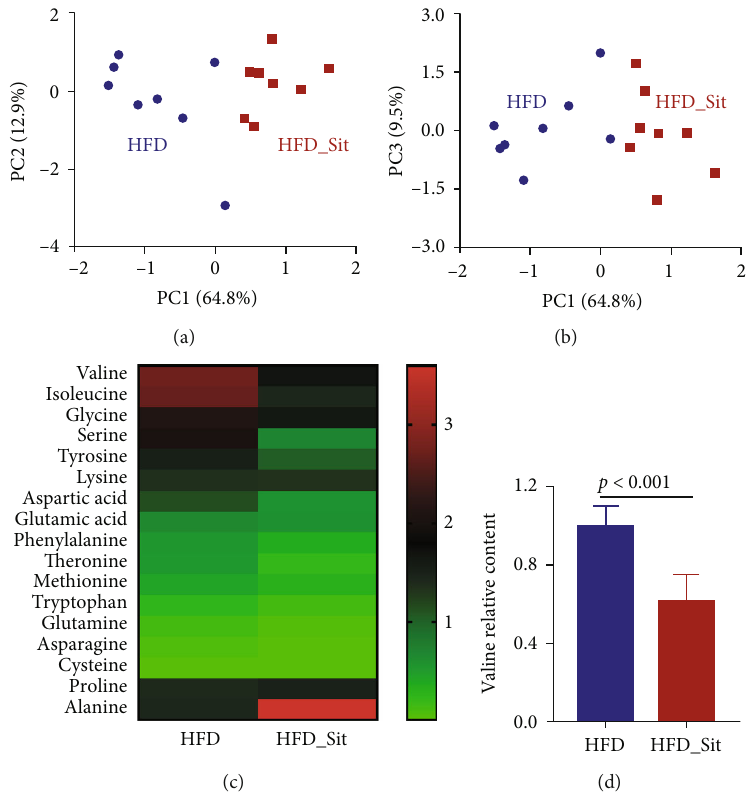
Figure 1: Sitagliptin treatment reduced the valine levels in HFD-fed mice. (a, b) Cluster analysis of the HFD-fed and HFD_Sit mice based on the amino acid concentrations using PCA. The principal components (PC1, PC2, and PC3) from the PCA are plotted for each sample. The percentage of variation covered in the plotted principal components is marked on the axes. Each group is labeled by a di ff erent symbol, and each spot represents one sample. (c) Heat map analysis of amino acid levels in the HFD and HFD_Sit groups. Each column in the heat map represents the group, and each row represents one amino acid. The color bar showing green to red indicates the relative level of each amino acid. (d) The relative level of valine in the HFD and HFD_Sit groups. (a – d) n = 8 ; data in (d) are presented as the means ± SD , t